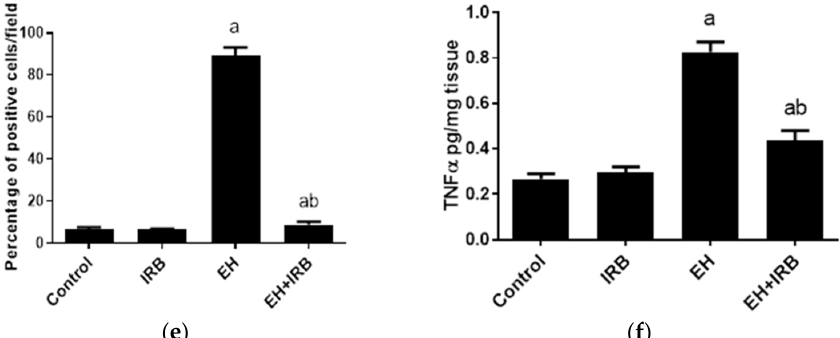
Figure 2. Effect of irbesartan (IRB) on uterine tumor necrosis factor-alpha (TNF α ) in estradiol benzoate-induced endometrial hyperplasia (EH) and atypia in rats. Images are from representative sections of the rat uterus ( × 400) stained for detection of TNF α in ( a ) control, ( b ) IRB-treated, ( c ) EH, and ( d ) EH + IRB-treated groups. A semiquantitative analysis of TNF α expression (percent of TNF α positive cells/field) ( e ), as well as the protein levels of uterine TNF α level (pg/mg tissue) as determined by ELISA ( f ), are shown. Results represent the mean ± SEM ( n = 6–7). a,b Significantly different ( p < 0.05) from control and EH groups, respectively.